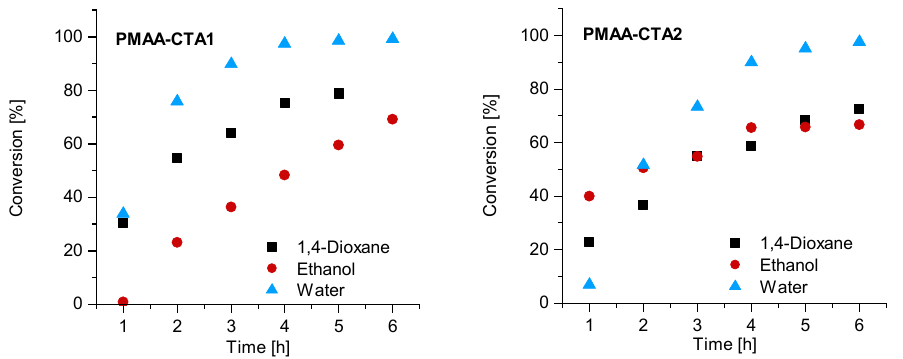
Figure 2. Reaction time versus conversion of the RAFT polymerization of PMAA with CTA1 ( left ) and CTA2 ( right ) with a molar ratio of [MAA]/[CTA] = 120 and [CTA]/[ACVA] = 10.